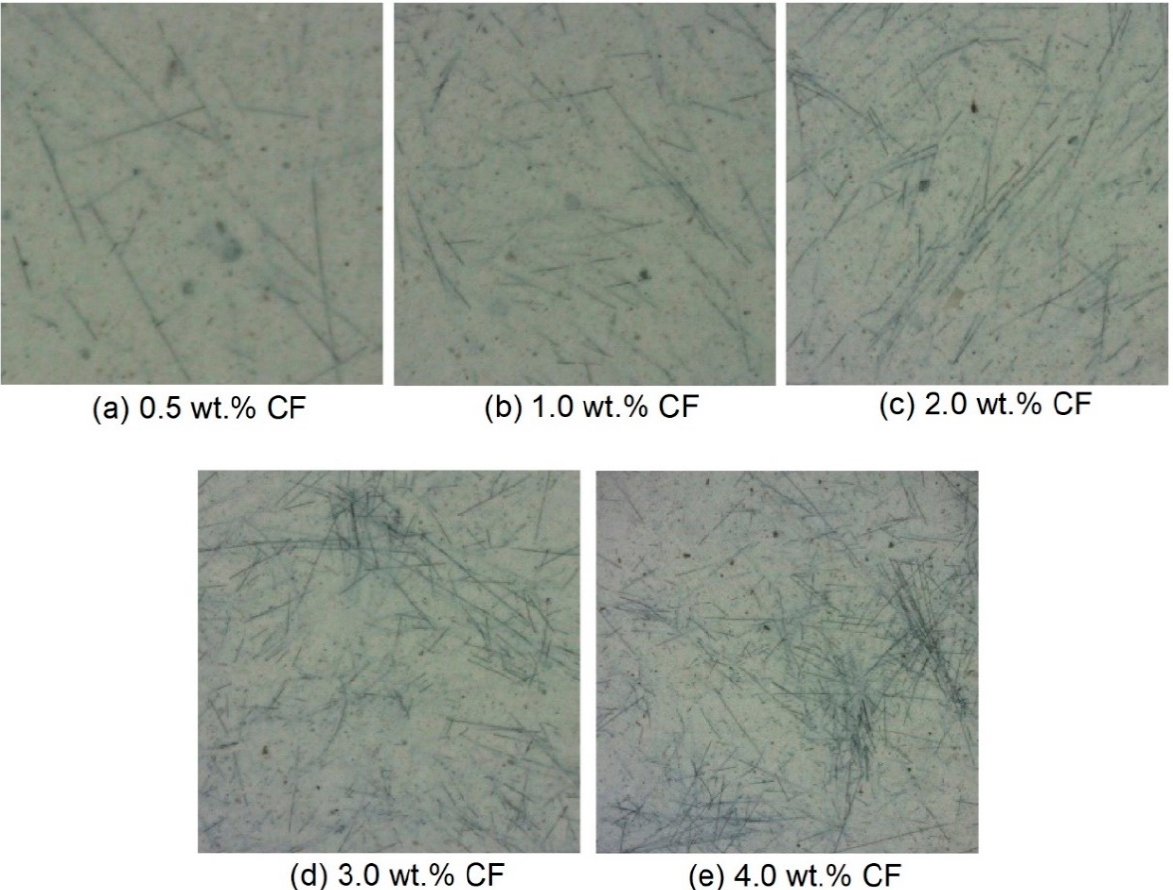
Figure 8. Original images of carbon fibers in the contact-hardening composites with different fiber contents: ( a ) 0.5 wt.%; ( b ) 1.0 wt.%; ( c ) 2.0 wt.%; ( d ) 3.0 wt.%; ( e ) 4.0 wt.%.